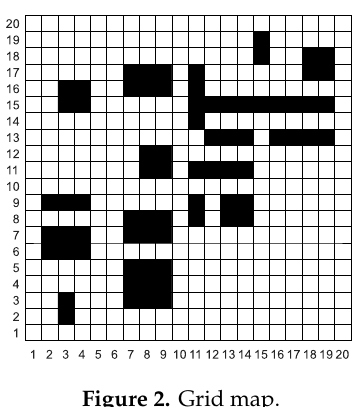
Figure 2. Grid Figure 2. Grid map. Figure 2. Grid map.